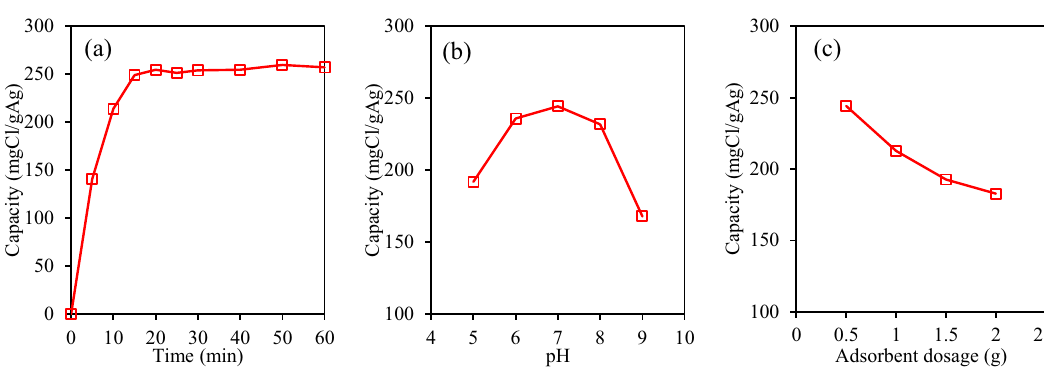
Figure 7. Effect of ( a ) adsorption time (dosage 0.5 g, 4.0 gCl/L, pH 7), ( b ) solution pH, and ( c ) adsorbent dosage on chloride removal.